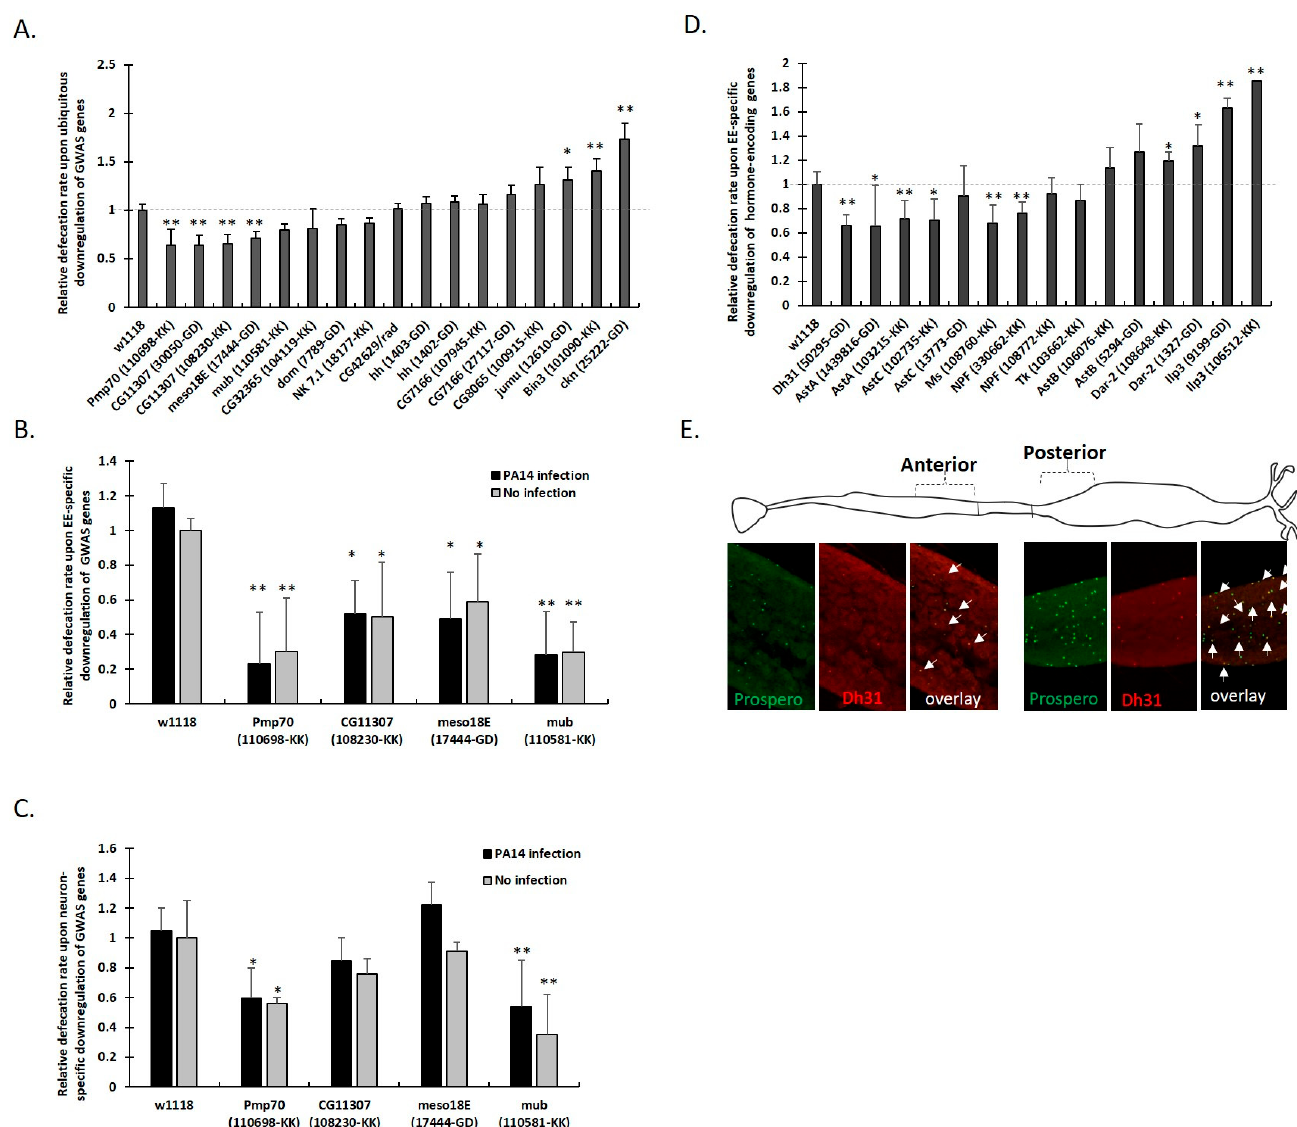
Figure 4. GWAS-identified and hormone gene downregulation either ubiquitously or specifically in EEs or neurons affects fly defecation rate. Fecal spots per fly per day upon ( A ) ubiquitous (via act-Gal4 UAS-RNAi ), ( B ) EE-specific (via prosV1-Gal4 UAS-RNAi ) and ( C ) pan-neuron-specific (via elav-Gal4 UAS-RNAi ) downregulation of indicated GWAS-identified genes, divided by that of the uninfected progeny of Gal4 crossed to w 1118 . ( D ) Fecal spots per uninfected fly per day upon EE-specific (via prosV1-Gal4 UAS-RNAi ) downregulation of hormone genes, divided by that of the progeny of Gal4 crossed to w 1118 flies. Each column represents the mean value of six biological replicates. Error bars represent standard deviation of the mean. Statistical significance using the Mann–Whitney U test indicated as * p < 0.05 or ** p < 0.01. ( E ) Schematic of the Drosophila midgut, indicating the anterior and posterior regions and the expression of Dh31-Gal4 UAS-mCherry-NLS reporter (red) that colocalizes with anti-Prospero antibody staining of EEs (green), indicated by white